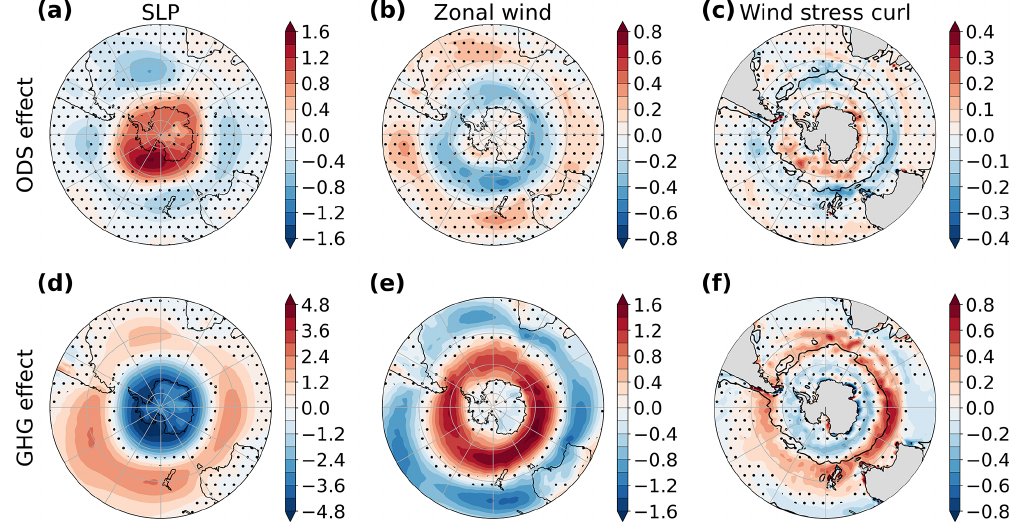
Figure 13. Changes in annual mean sea level pressure ( a , d ; hPa), surface zonal wind ( b , e ; ms − 1 ), and wind stress curl ( c , f ; 10 − 7 Nm − 3 ) due to ozone recovery (a–c) and GHGs (d–f) . The stippling masks regions where the changes are not significant at the 95% confidence interval based on a two-tailed t test. The contour in (c) and (f) marks the location of zero-wind-stress